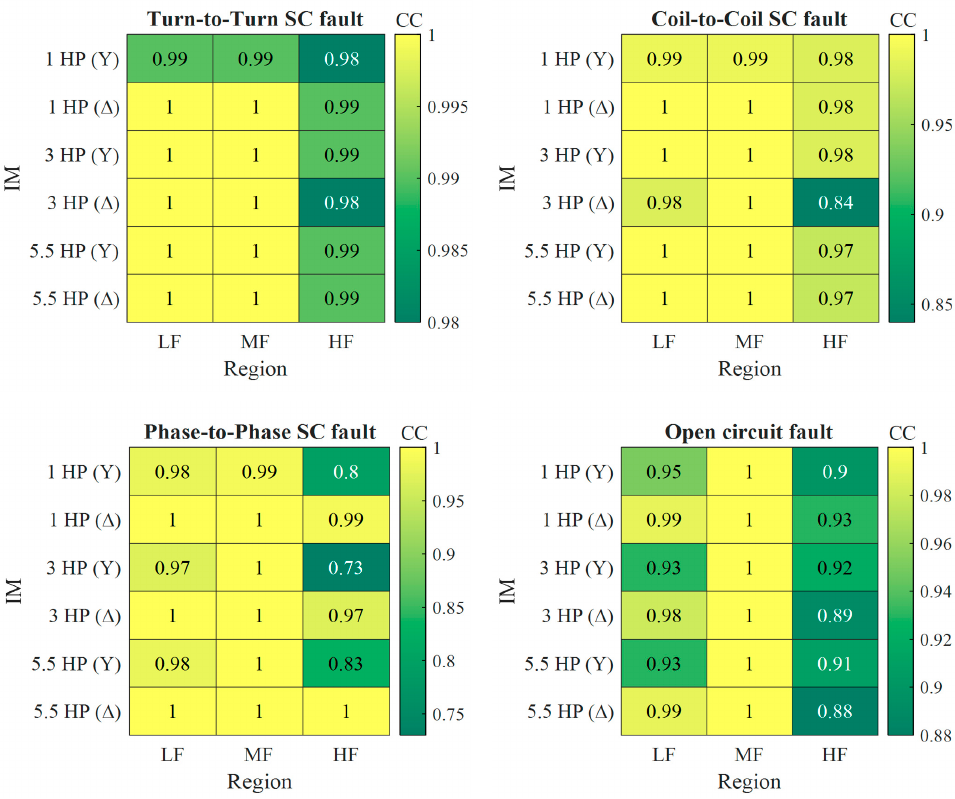
Figure 9. The CC calculated values between the normal and other faults. The ASLE value in Equation (4) can display the variation between the two datasets when its value is above 1.5 [33]. In this study, the ASLE values indicate the variation when the calculated value is higher, as indicated by the bright yellow color in Figure 10. The ASLE indicates variation in the LF region for the Turn-to-Turn SC fault and in the HF region for the 3 HP IM. The ASLE also indicates values of above 1.5 in the MF and HF regions for the Coil-to-Coil fault, while it only indicates that in the LF region for the 3 HP Y-connected IM. For the Phase-to-Phase SC fault, the ASLE shows huge values of above 3.10 for the Y-connected IM. The ASLE values for the ∆ connection are below 1.5 only in MF and HF regions for the 3 HP ∆ -connected IM. Eventually, the ASLE shows huge values in all of the FRA regions for the OC fault. ∑ |20𝑙𝑜𝑔 (cid:2869)(cid:2868) 𝑌 (cid:3036) (cid:3398) 20𝑙𝑜𝑔 (cid:2869)(cid:2868) 𝑋 (cid:3036) | (cid:3015) (cid:3036)(cid:2880)(cid:2869) ASLE (cid:4666)(cid:3025),(cid:3026)(cid:4667) =